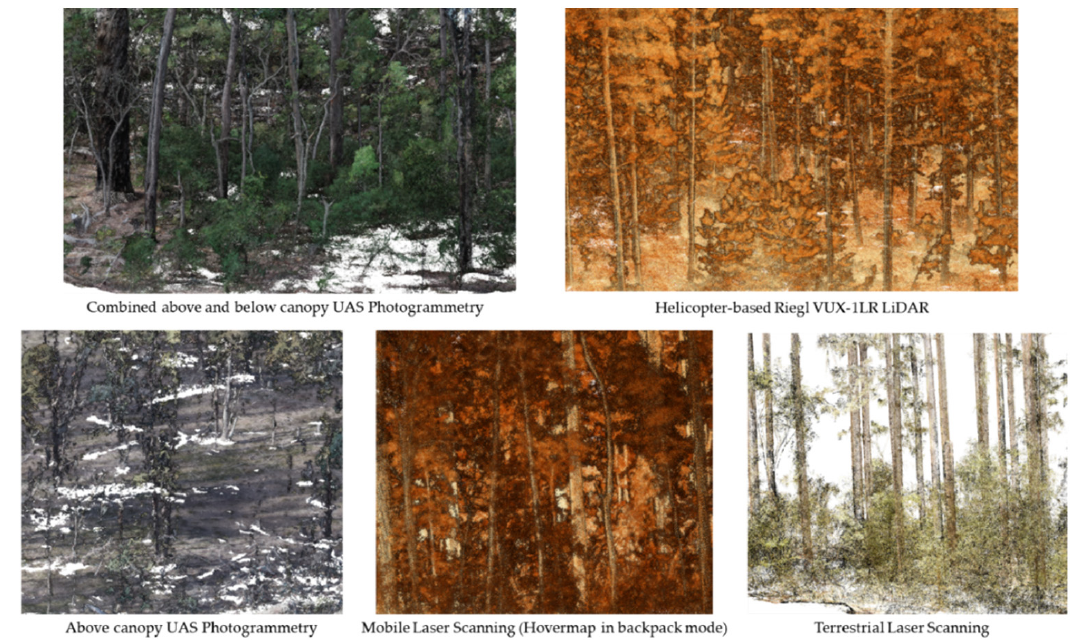
Figure 18. A qualitative demonstration of the Forest Structural Complexity Tool on five diverse point cloud datasets is provided here: https://youtu.be/rej5Bu57AqM (accessed on 19 November 2021).